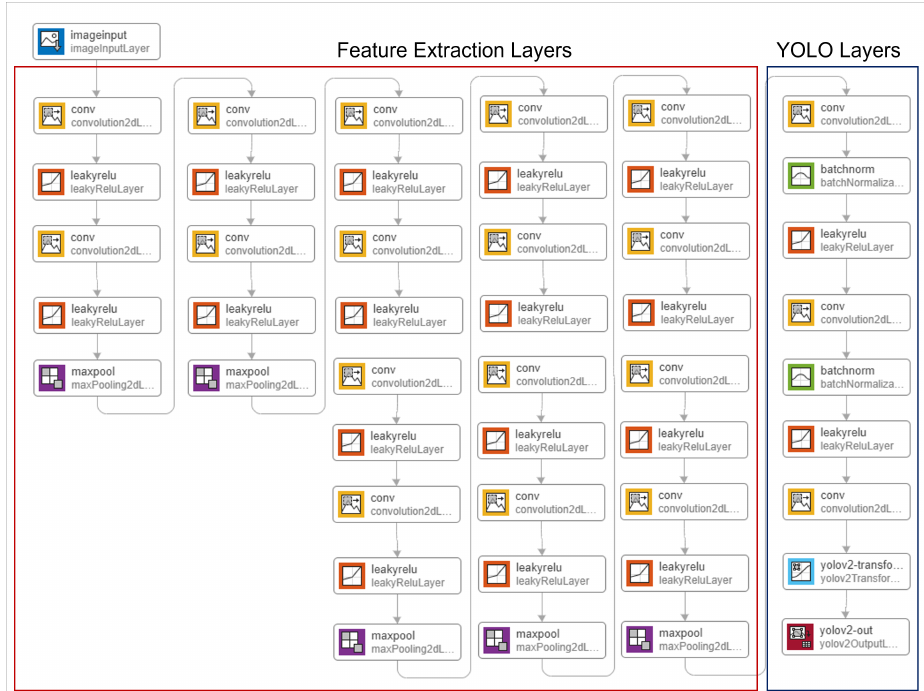
Figure 9. YOLOv2 with VGG19 feature